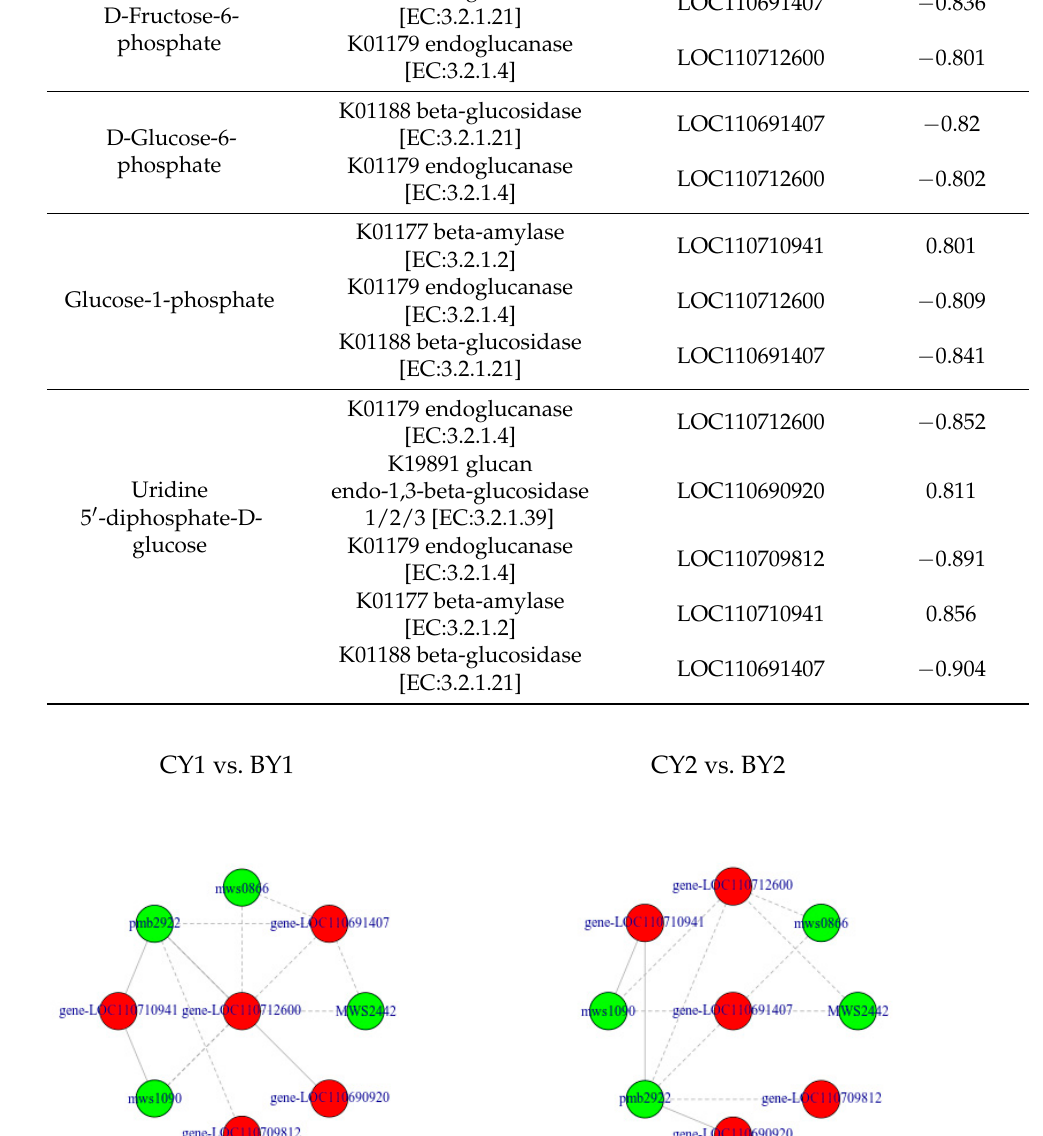
Table 3. Metabolite – gene correlations.